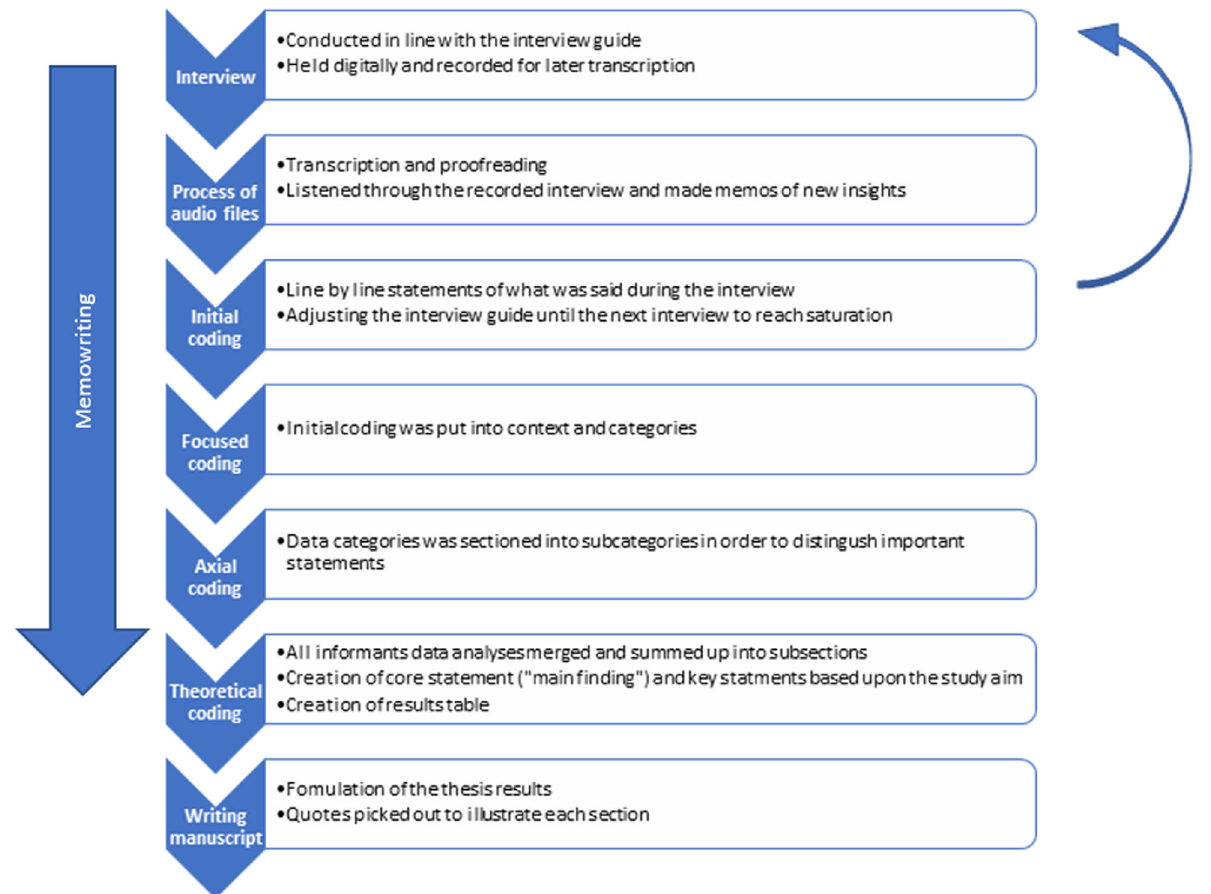
Fig. 1 The analytic process. Initial coding adds depth before new interviews take place. The authors ’ aspects of the content are written as memos along the process and adds up to the fi nal result of a core statement and supportive key statements.